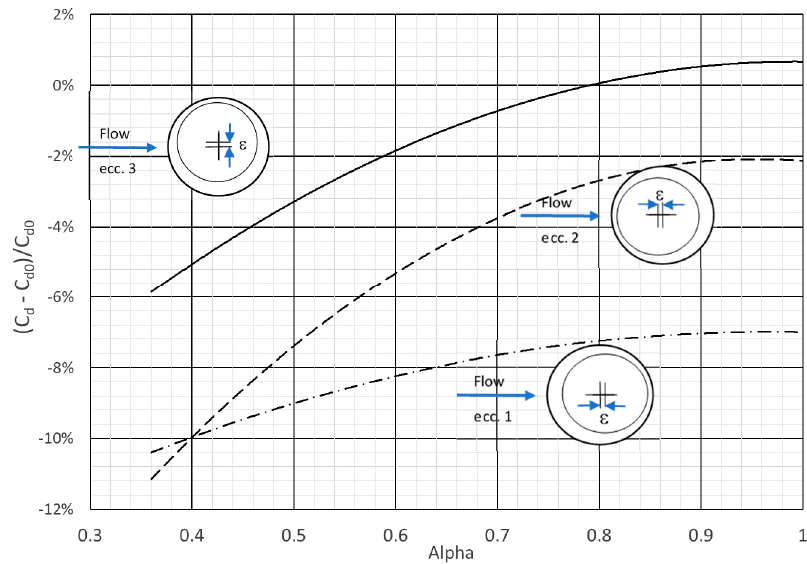
Figure 10. Sensitivity of change in C d with alpha for eccentric cases ε 1, ε 2, and ε 3.